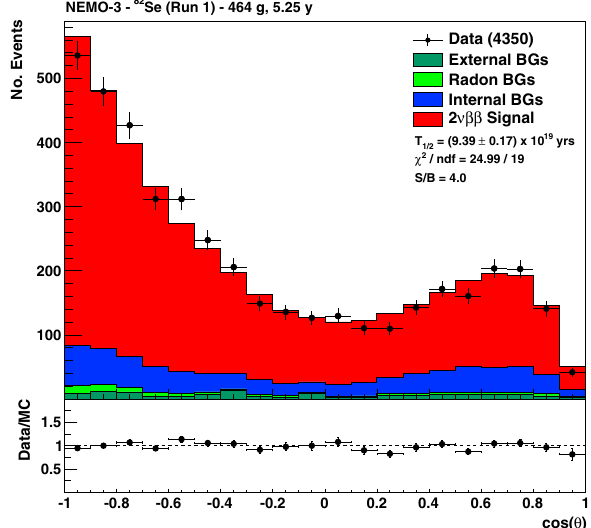
Fig. 9 Distribution of the cosine of the angle between two electron tracks at the point of emission from the run 1 source foil in the ββ chan- nel. As expected, more events are observed with electrons emitted to back-to-back than with smaller opening angles. This angular distribu- tion has been reweighted based on data from 207 Bi calibration